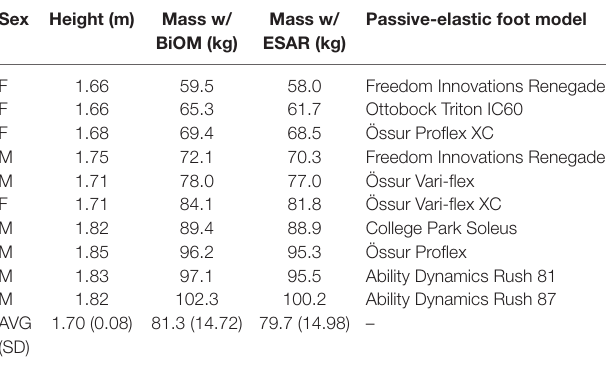
TaBle 1 | Subject anthropometrics and their own passive-elastic prosthetic foot model.